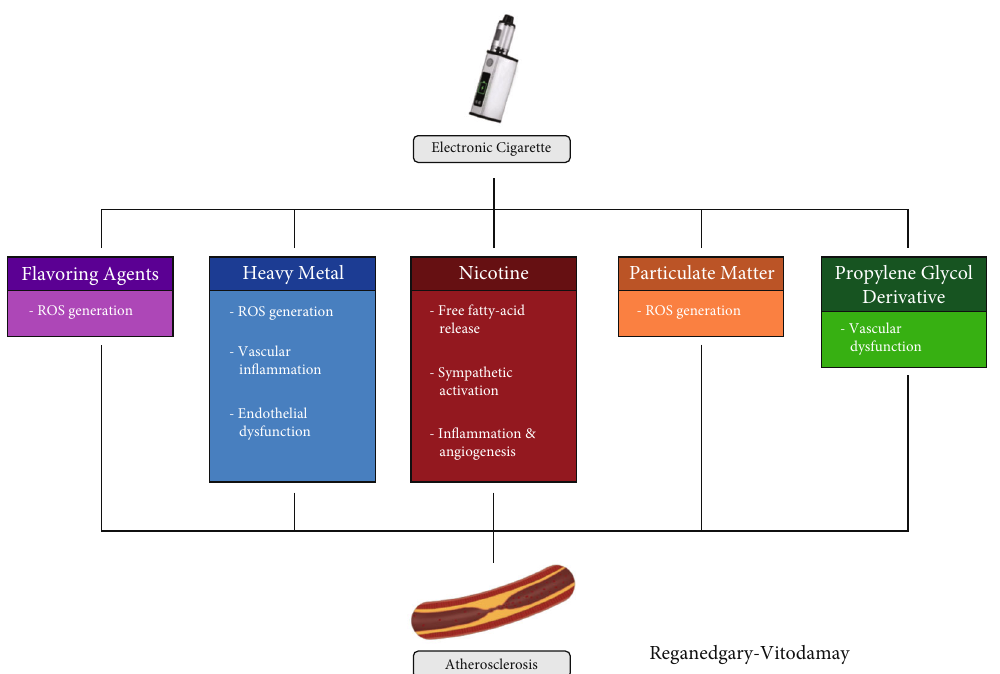
Figure 2: Chemical constituents of e-cigarette and their e ff ects on